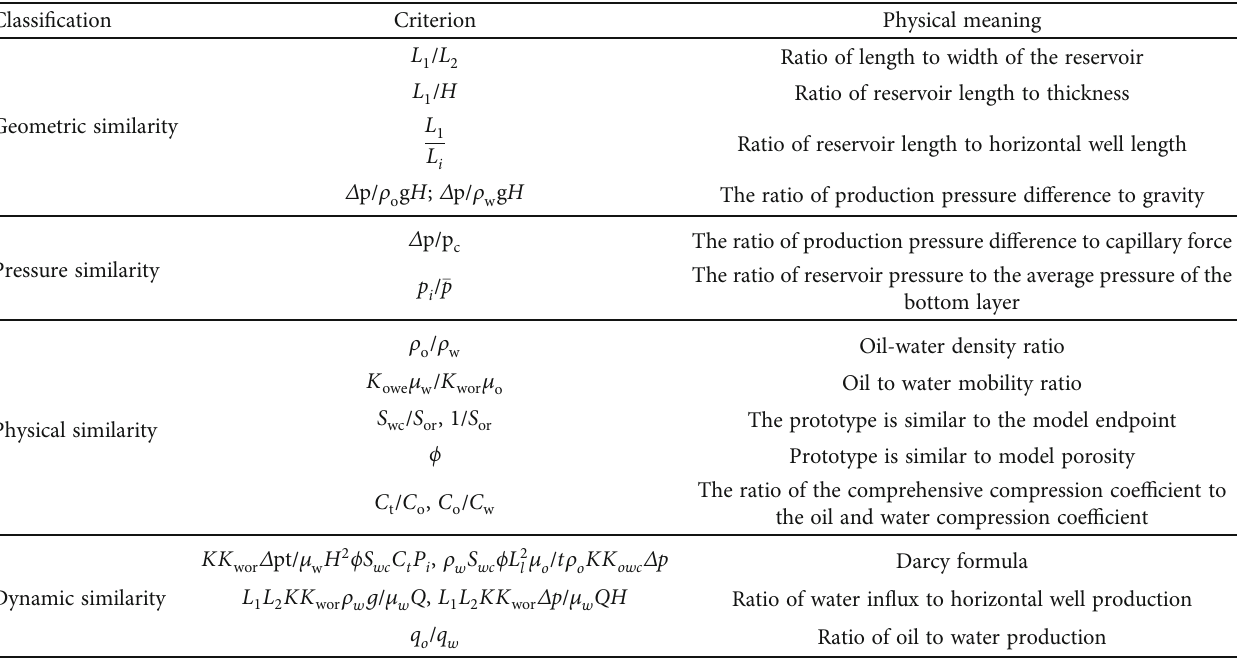
Table 1: Similarity criterion.